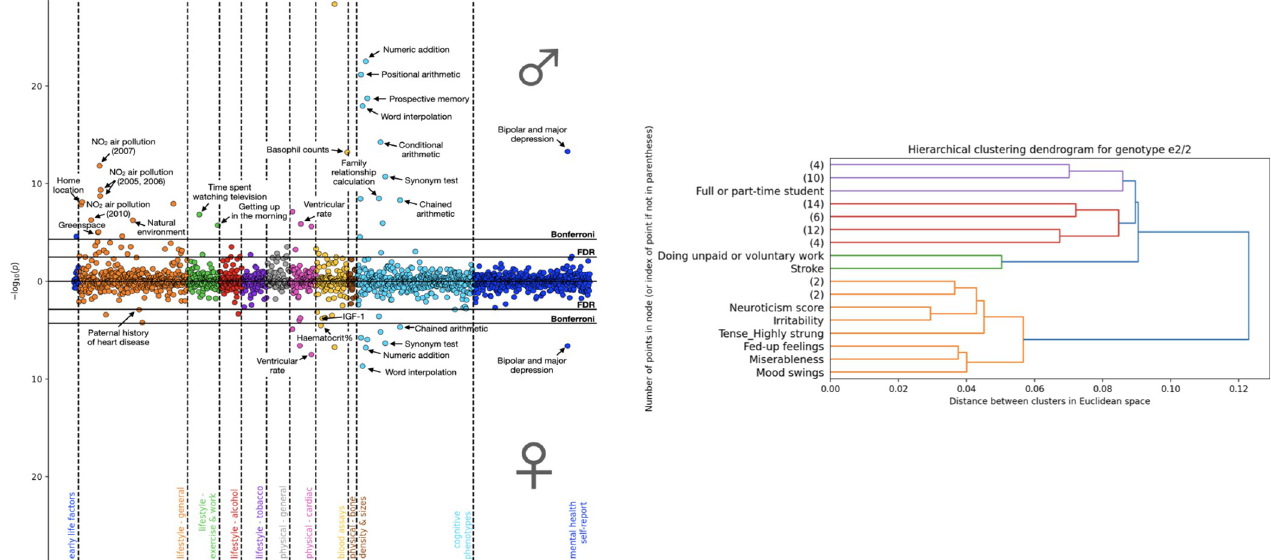
Fig 1. Relationship of risk factors to hippocampus–DN signatures is both sex specific and APOE genotype specific. Savignac and colleagues [5] created 25 summaries of hippocampus and default network (DN) subregion brain volume measures and then ranked by how strongly each subregion summary was associated with genetic risk conferred by the individual’s APOE genotype. The left-hand diagram illustrates the correlations between brain volume summaries in the region most reflective of genetic risk and phenotypic measures, separately for men (top dots) and women (bottom dots). Cognitive measures (turquoise dots, second to right block) and depression (dark blue, right block) were associated with brain volume for both sexes, as were cardiovascular risk factors (magenta dots). Air pollution measures were associated only for males (orange dots, second to left). This shows a sex-specific pattern of association between risk factors and volumetrics for hippocampal subregions most strongly associated with genetic risk. The investigators also examined the correlation of risk factors with hippocampus–DN signatures separately for each of the six APOE genotypes and grouped risk factors into clusters with similar patterns of association. The right-hand diagram shows risk-factor groupings for the ε 2/2 genotype. The orange cluster at the bottom of the diagram shows that similar brain volume patterns occur within this genotype for traits typically associated with neuroticism such as irritability, miserableness, and mood swings. This suggests that the overall protective effect of the ε 2/2 genotype may be modified by personality